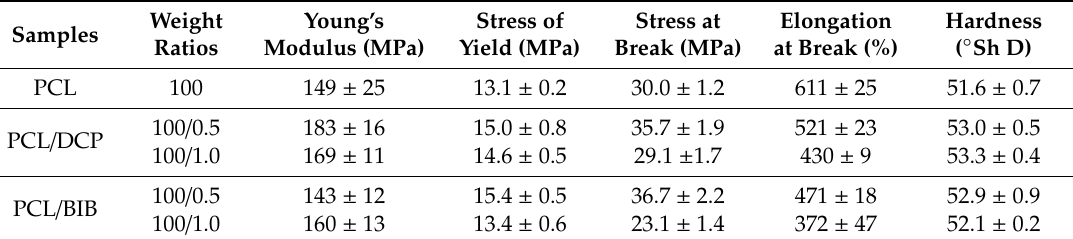
Figure 8. The stress–strain curves for PCL modified by BIB peroxide. Table 4. The mechanical properties of PCL and PCL modified by